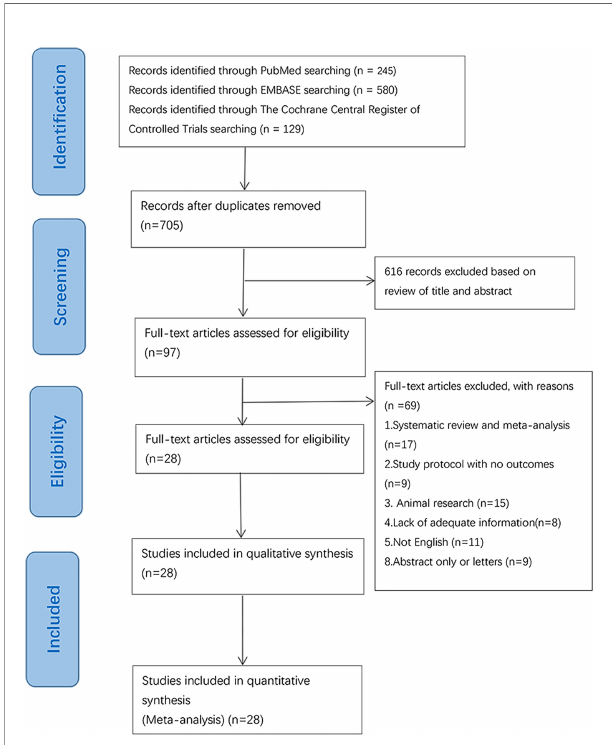
FIGURE 1 | Flowchart of database searching and study identi fi